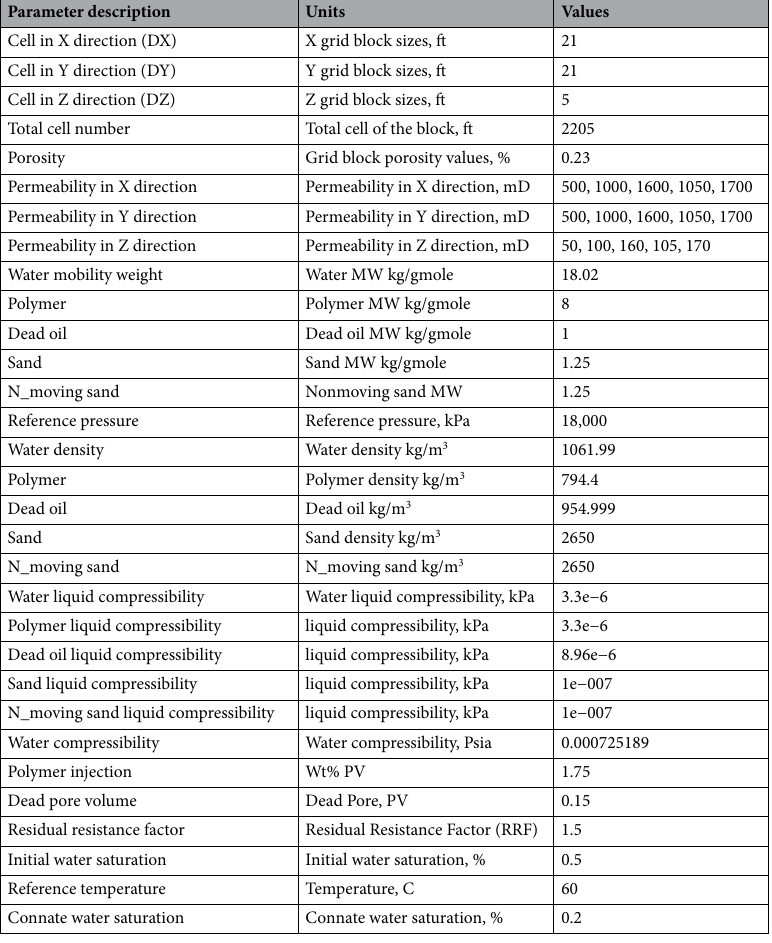
Table 1. Base case model description and physical properties of the test scenarios.